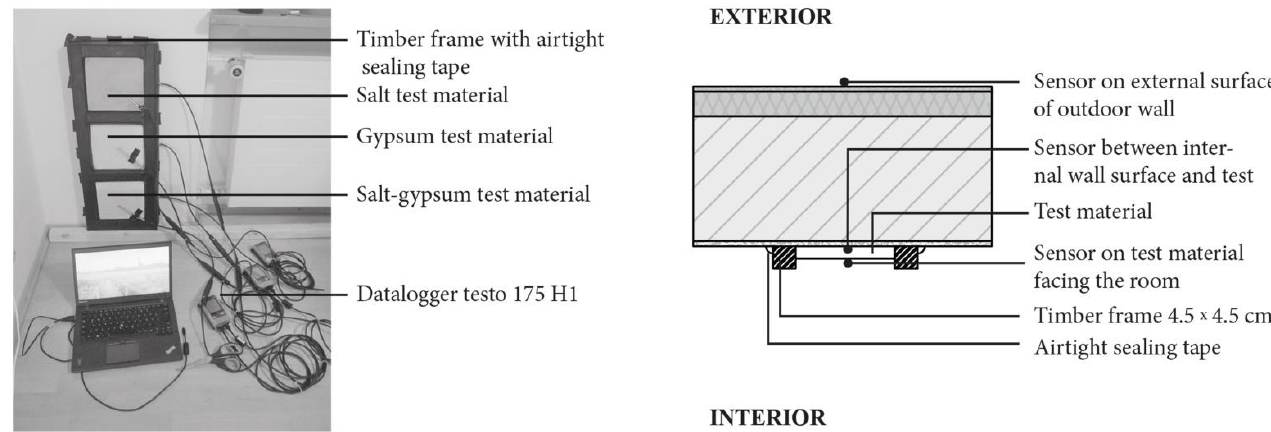
Figure 4. Left : Test panel. Right : Horizontal section through the test panel installation.